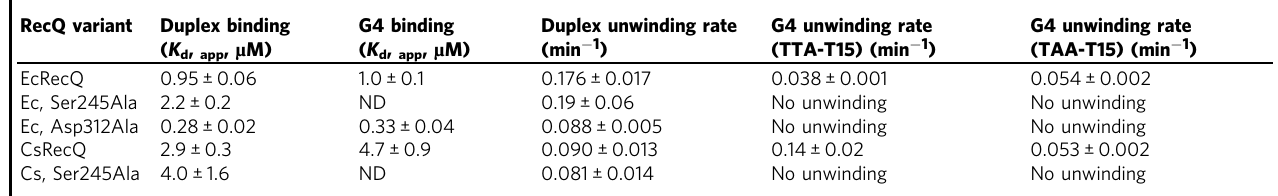
Table 2 DNA binding and unwinding rates of bacterial RecQ variants RecQ